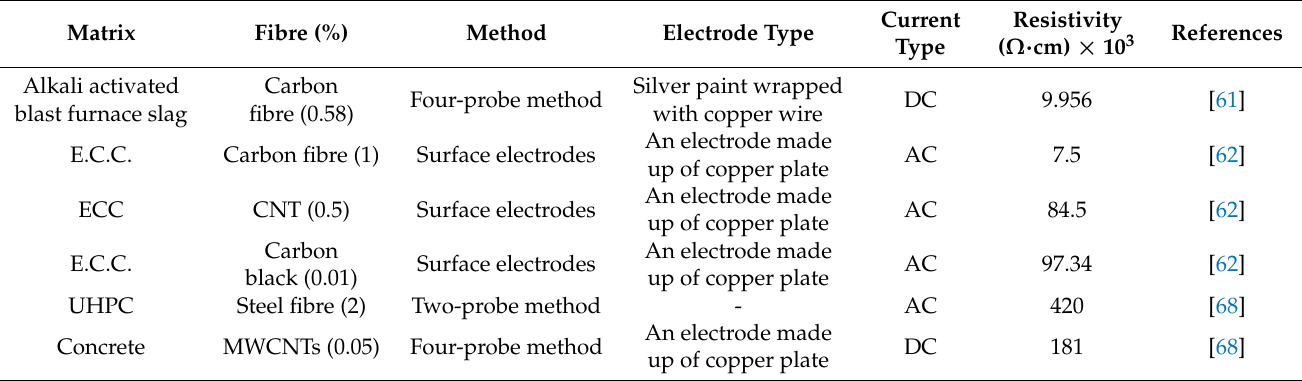
Table 7. The resistances for the different types of circuit current. Table 6. Resistivity of materials according to contact